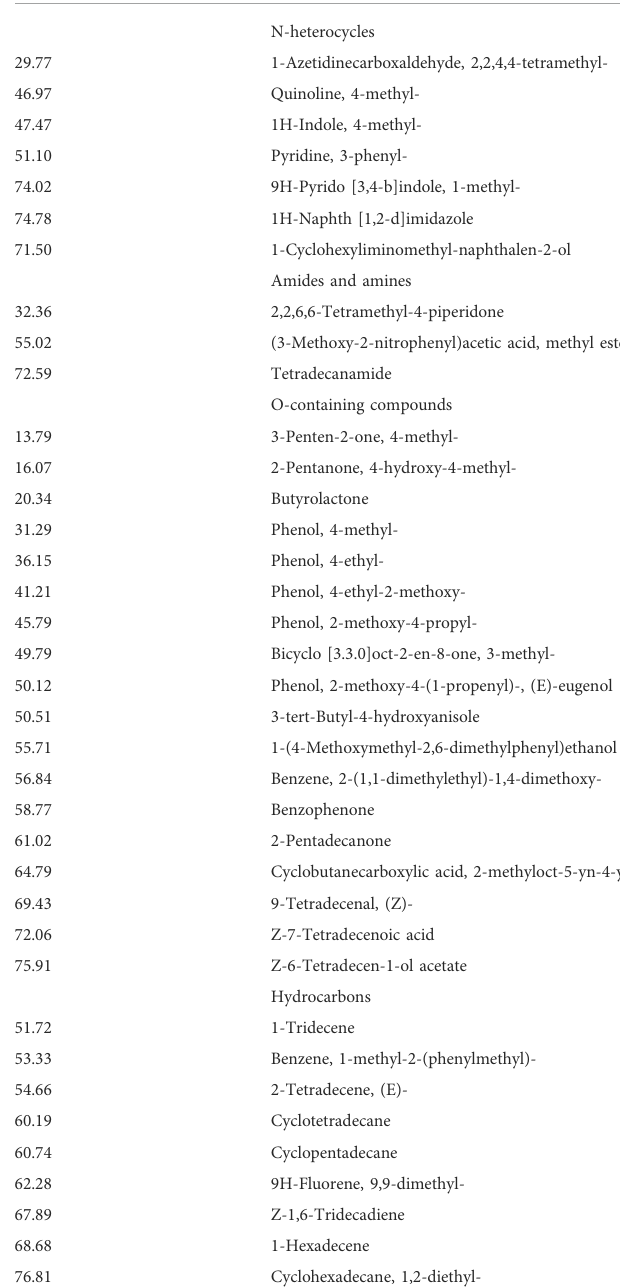
TABLE4Identi fi edmaincomponentswithrelativeareapercentageinthetotalionchromatogramofbiocrudeobtainedfromcontinuous fl owHTLof SS at 350 ° C with 8 min RT (retention time).